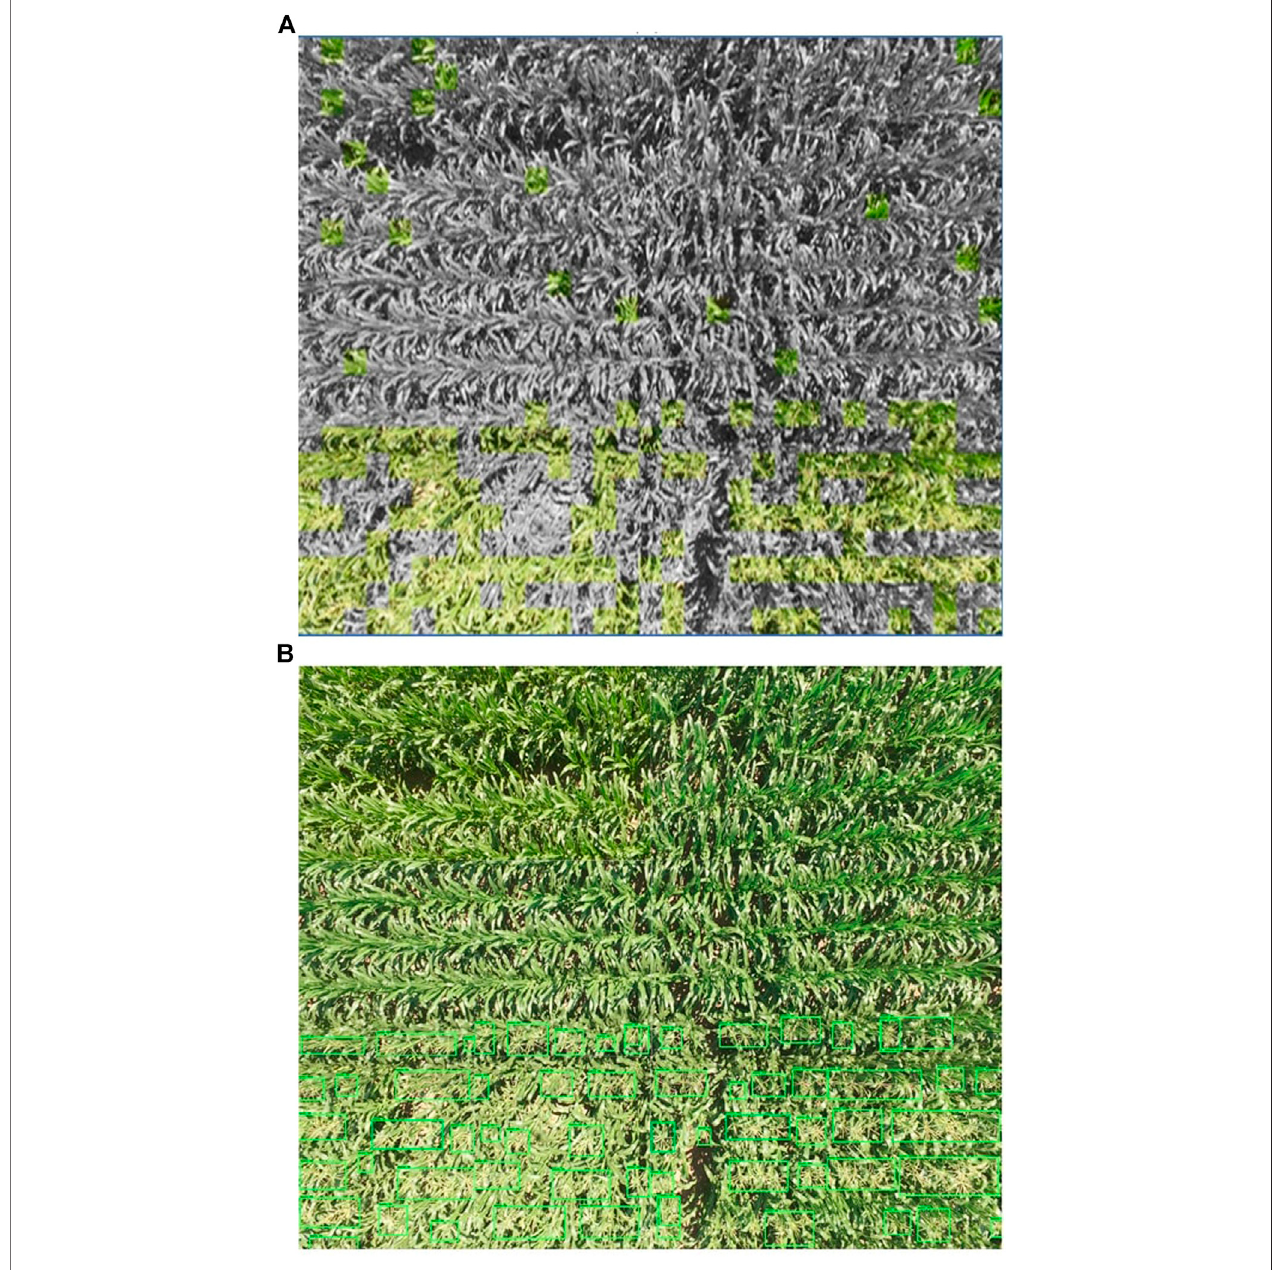
FIGURE 11 | Visualizing an example of tassel detection outputs of the same full UAV image of size 3000 × 4000 pixels for both (a) TD-CNN, the grayed areas are no_tassels, the colored areas are “ tassels. ” (b) Faster R-CNN, the green boxes are tassels.